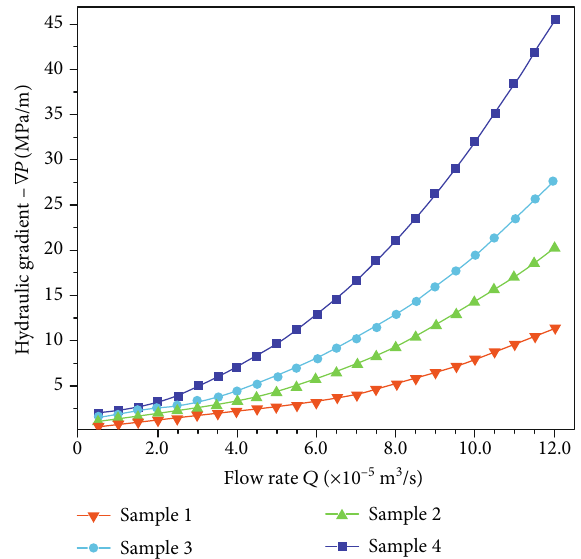
Figure 10: Pressure gradient versus fl ow rate for the